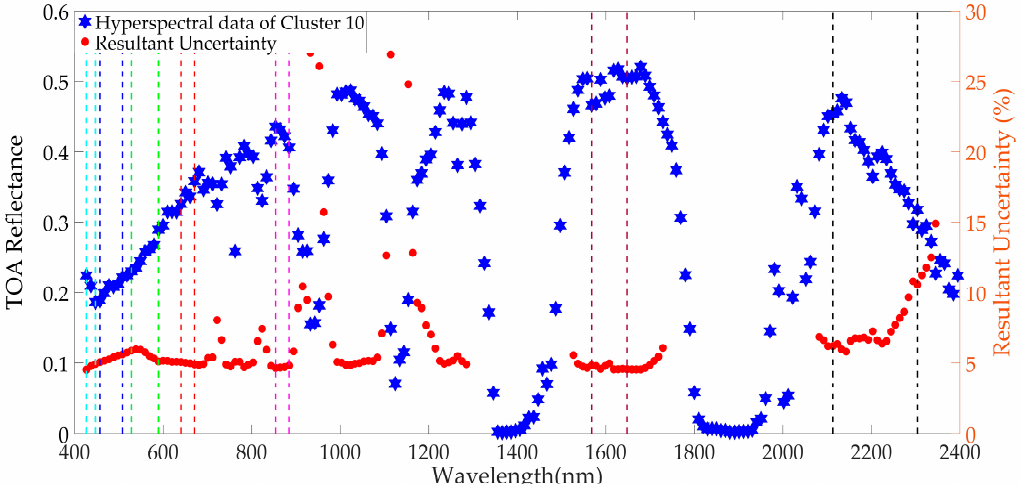
Figure A7. Estimated representative hyperspectral profile of Cluster 9 and its resultant uncertainty.